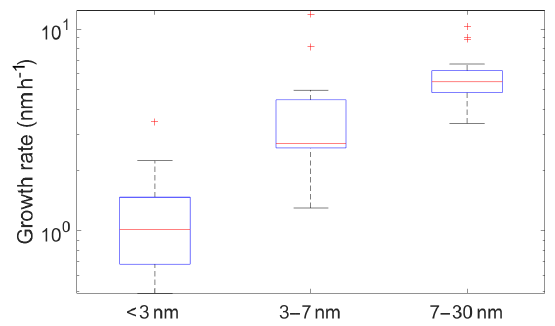
Figure 16. Growth rates of cluster mode and nucleation mode par- ticles generated from NPF events. The lines in the boxes represent the median value, the lower part of the boxes represents 25% of the growth rates and the upper part of the boxes represents 75% of the growth rates. Data marked with red plus symbols represent